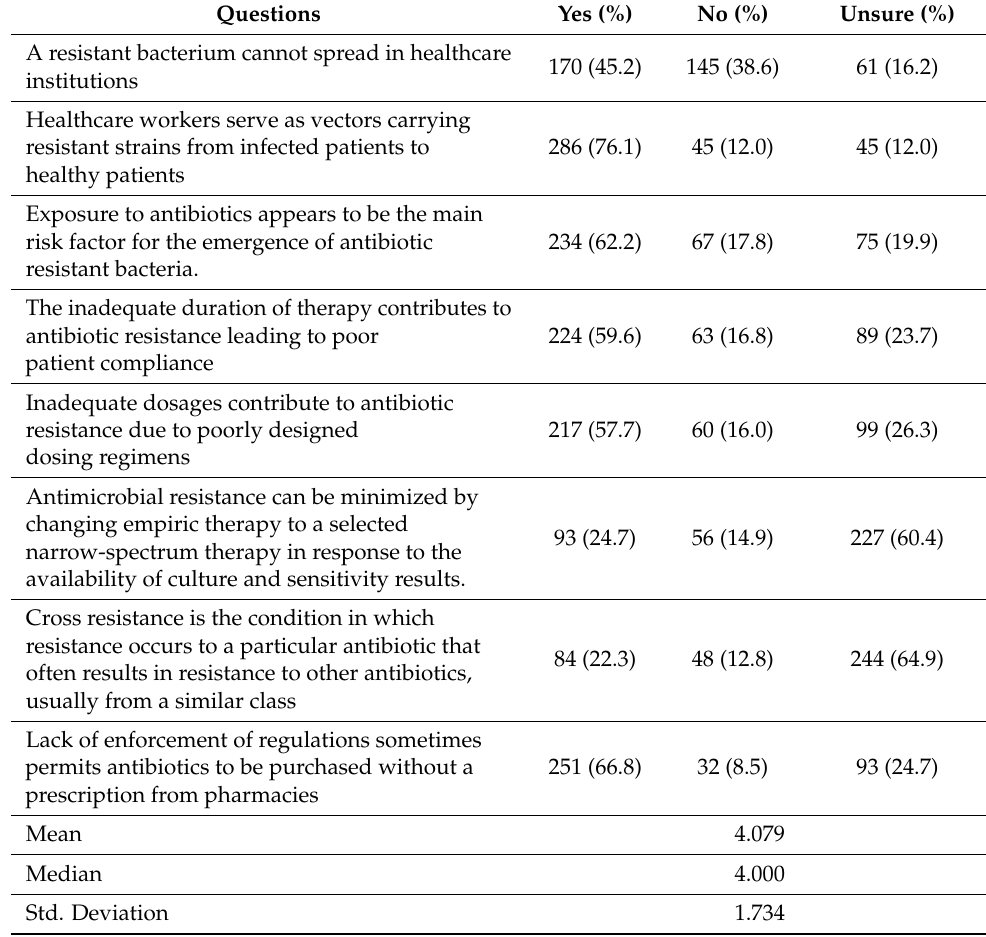
Table 3. Understanding of pharmacy technicians about antibiotic resistance (n =